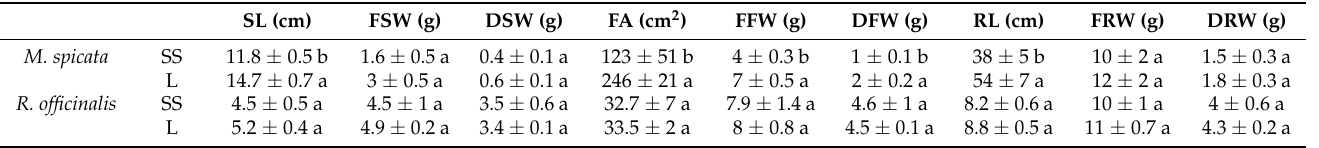
Table 2. Morphometric parameters in M. spicata and R. officinalis plants under fertilization treatments.